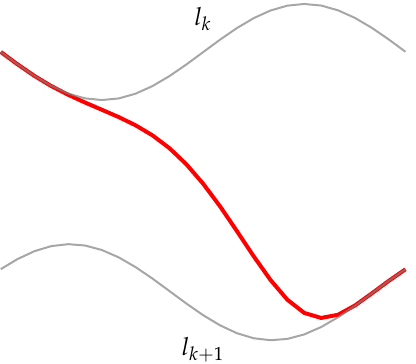
Figure 6. Two local curves ( l k and l k + 1 ) blended together to create a blending spline (red curve).